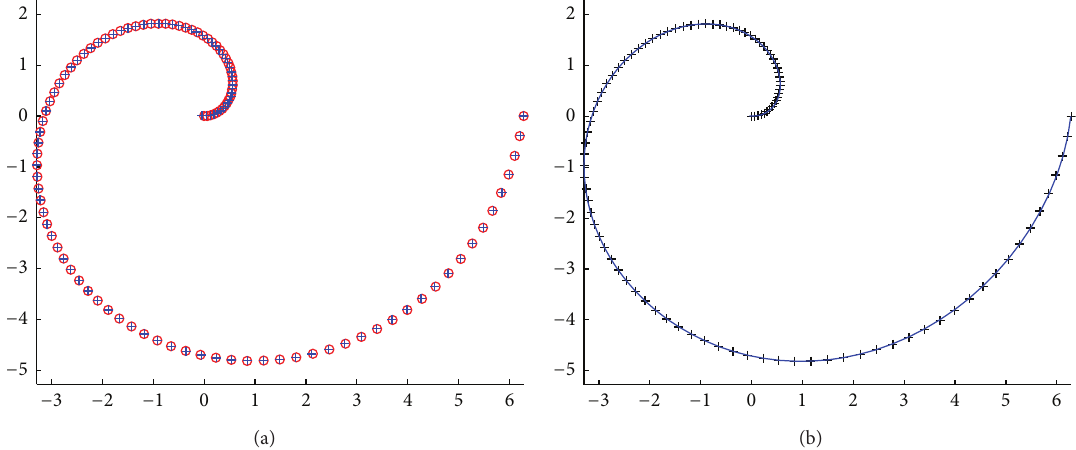
Figure 2: Application of the cuckoo search algorithm to the Archimedean spiral curve: (a) original data points (red emptied circles) and reconstructed points (in blue plus symbol); (b) data points (black plus symbol) and fitting curve (solid blue